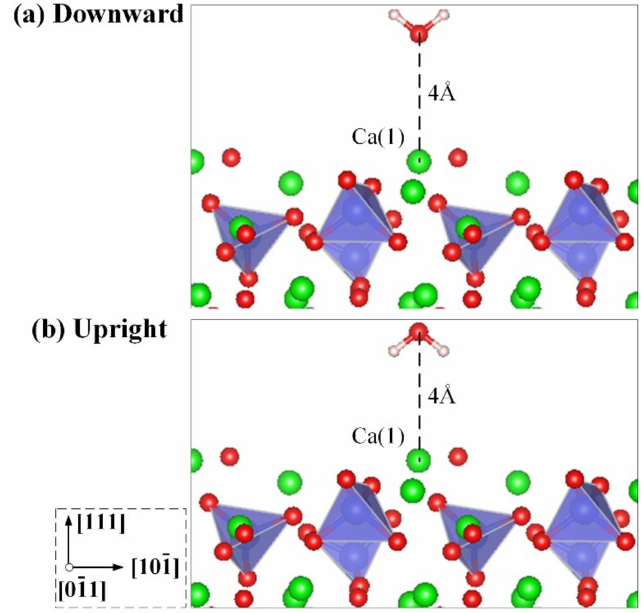
Figure 2. Initial configurations of a water molecule on the top of the M3-C 3 S (111) surface: ( a ) downward and ( b ) upright. White spheres indicate